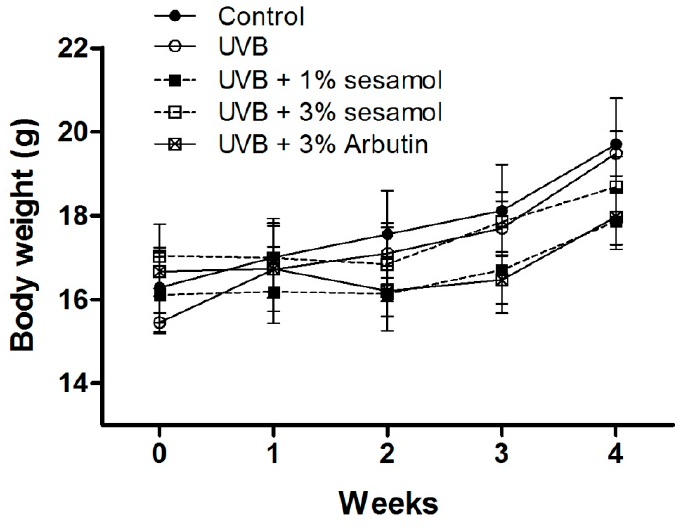
Figure 2. Body weight variation of C57BL / 6 mice receiving topical application of sesamol during the 4-week study period.